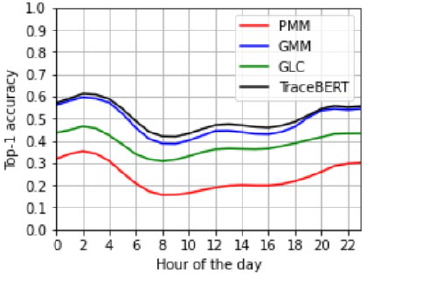
Figure 3. Top-1, top-3, and top-5 prediction accuracy scores (from left to right ) over the 24 h of the day.